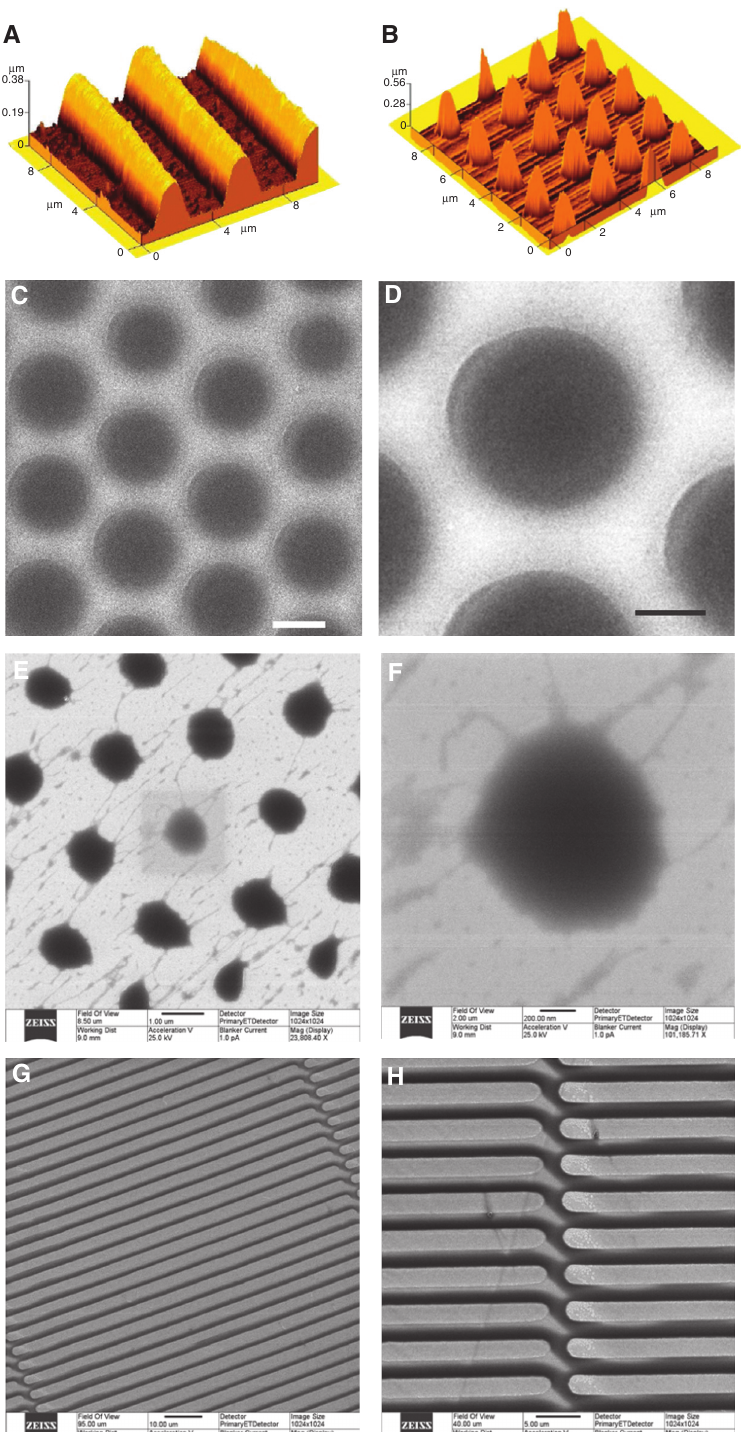
Figure 8 AFM (A, B) and HIM (C–H) images of PET imprinted films with 2D (lines) or 3D (dots) type of geometrical confinement. (C) and (D) portions are different magnification HIM images of an as-prepared film PET film; (E) and (F) show the morphology of the same film after its annealing at temperature 5 ° above the T of PET; (G) and (H) show different magnification HIM images of a PET film with imprinted parallel m lines (no sign of surface crystallization can be seen before or after annealing). AFM images do not allow high-resolution characterization of the film surface (especially) between the nano-imprinted features due to high local curvature and surface roughness of the